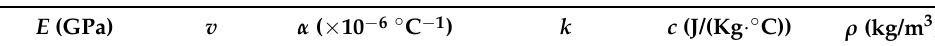
Table 4. Material parameters of ZrO 1.5 -YO 1.5 -TaO 1.5 for TC2 layer.